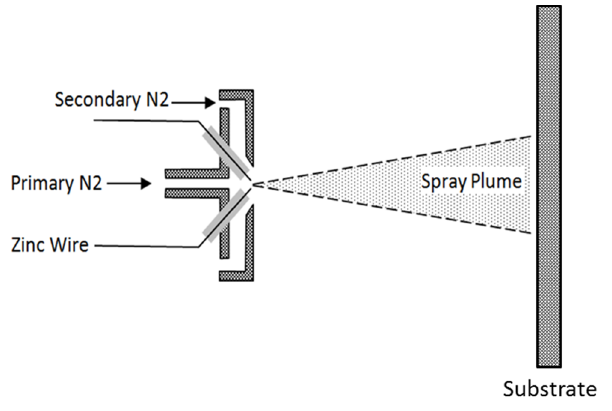
Figure 1. Schematic showing the torch working principal, general relationship between primary and secondary atomizing gases, and approximate substrate—spray plume